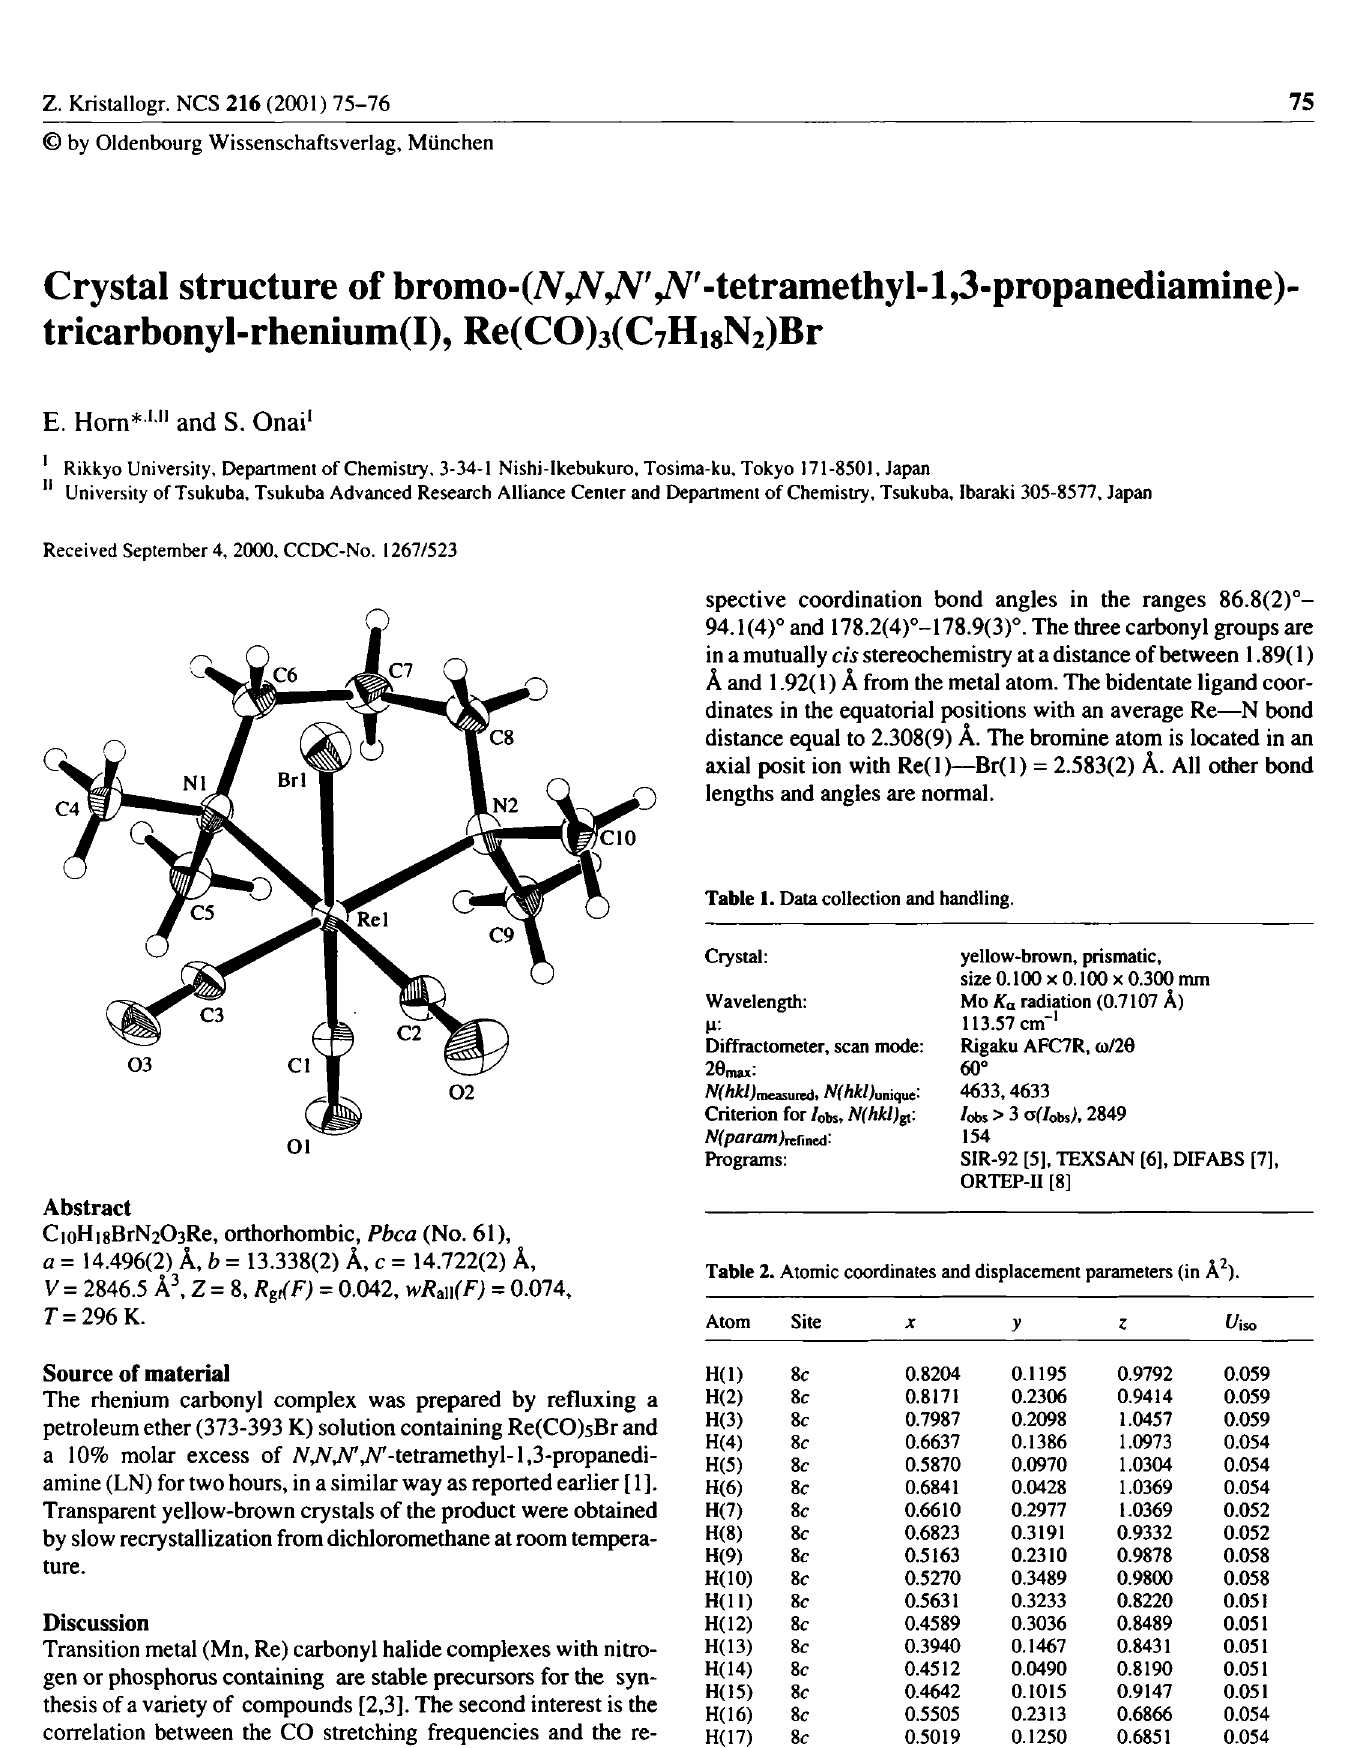
Table 2. Atomic coordinates and displacement parameters (in Ä 2